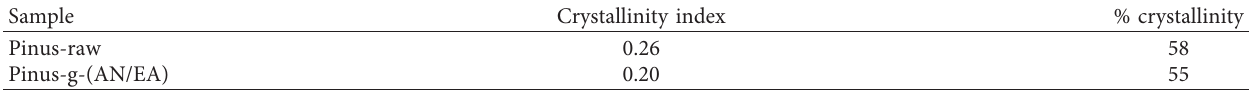
Table 1: Crystallinity index and % crystallinity of pinus-raw and